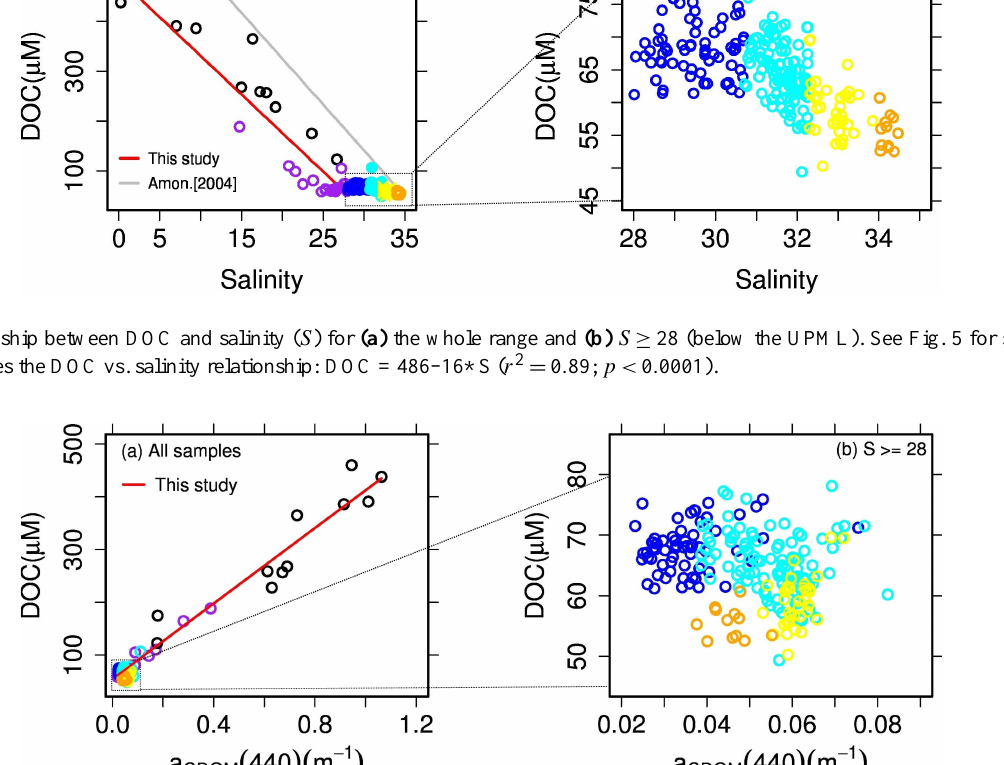
The relationship between a CDOM (440) and salinity